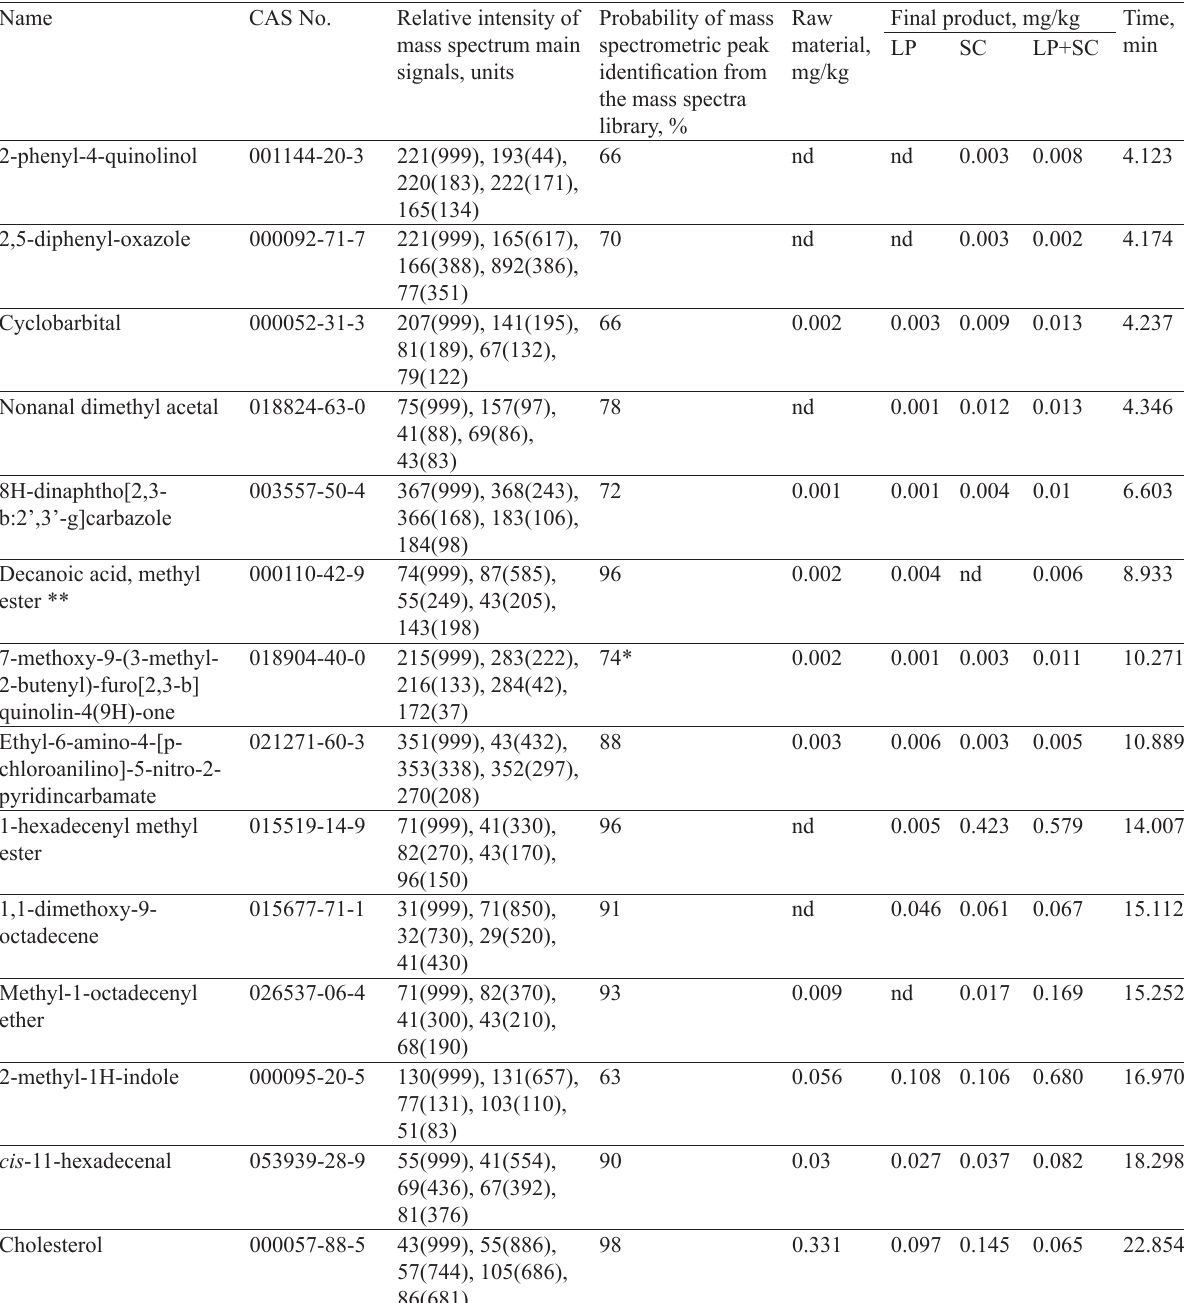
Table 5 Chemical components in products with Lactobacillus plantarum and Staphylococcus carnosus (n = 6, P =